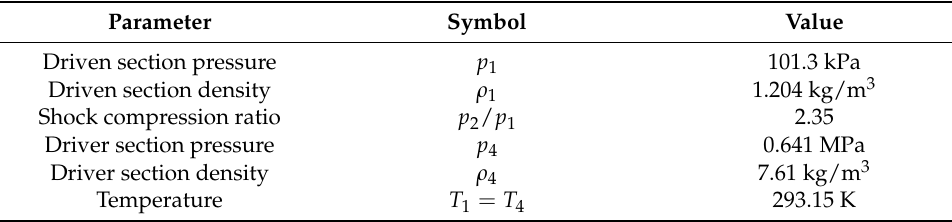
Table 1. Shock tube flow parameters.